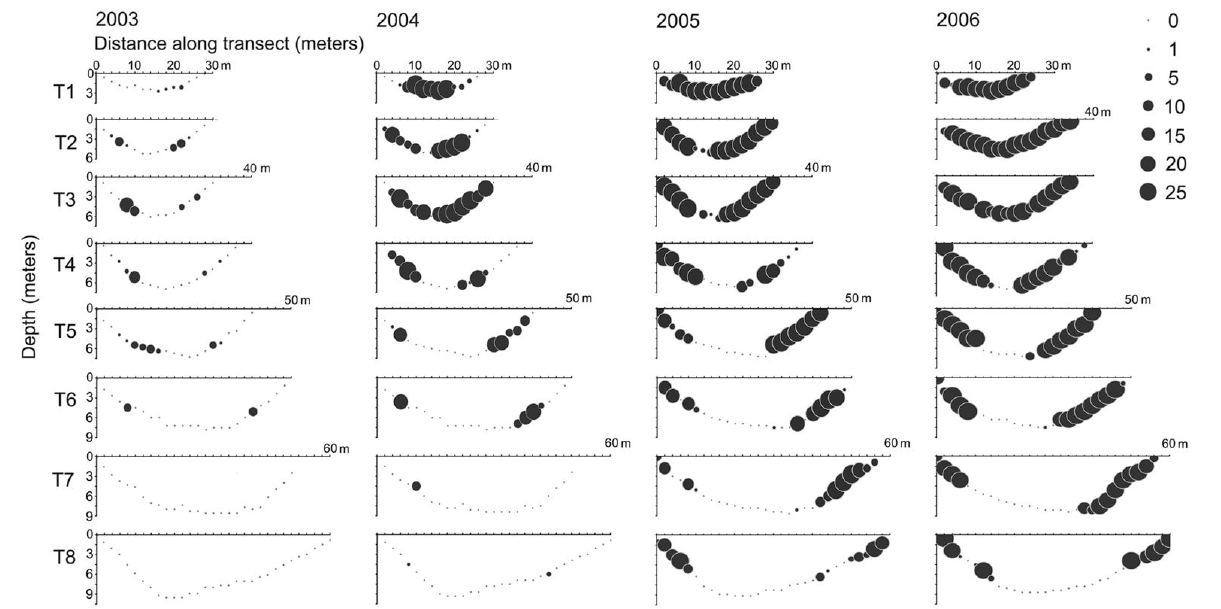
Figure 3. The early stages of establishment and expansion of the introduced population of Exaiptasia pallida , documented along eight line transects that transversed the side-arm of Jellyfish Lake (shown in the NW corner of the lake in Figures 2 and 4 ), from 2003 to 2006. Transect #1 (T1) is immediately in front of the visitor’s dock, and subsequent transects (T2–T8) are spaced at ~6 m intervals; see Figure 4 for location of Transect 1, 4 and 8. The x-axis shows distance along transects in an approximately west-east orientation. Sampling intervals of 2 m are indicated by light grey dots, and E . pallida presence is indicated by a black circle, the area of which is proportional to E . pallida abundance. The scale at the top right corner represents the proportion of E . pallida abundance, i.e., the number of squares in each 0.5 x 0.5 m quadrat with at least one E . pallida